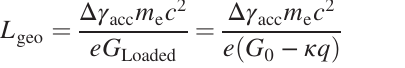
FIG. 2. Reduced case quantities for single bunch as a function of geometrical length. Left vertical axis: normalized charge q (cid:2) ¼ κ q=G 0 (dashed blue), efficiency normalized to its maximum η — see derivation in Appendix B. Right vertical axis: 1 ; max (red) unloaded gradient (turquoise) and loaded gradient (dotted